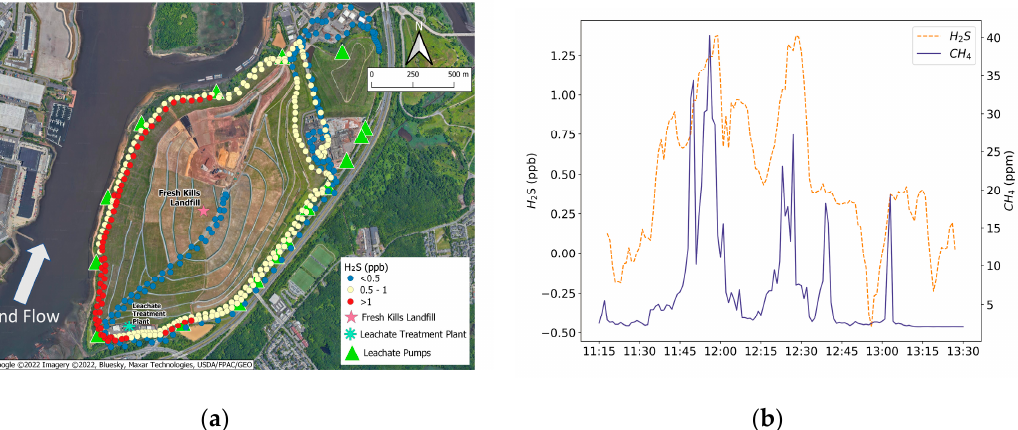
Figure 4. Fresh Kills Day 1, 2 November 2021: ( a ) Loops driven around Fresh Kills and the associated H 2 S measurement MRs, binned and indicated by color. Each loop was slightly offset to the right and below the prior loop to prevent overplotting. The wind flow vector in the bottom left depicts the average wind direction for the period of measurements. The wind direction was consistent for the duration of the measurements. ( b ) The 1-minute time-series plot of both H 2 S (ppb) and CH 4 (ppm) for the entire period of